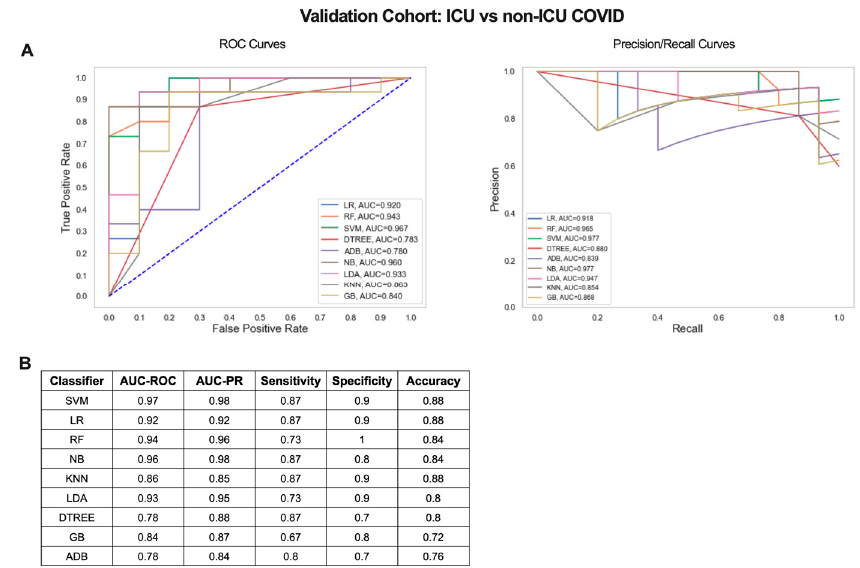
Figure 6. Critical vs. non-critical COVID-19 classifier gene signature validation results. ( A ) ROC and PR curves and ( B ) table of performance metrics for ML results using the 20 gene signature from Figure 4D to compare ICU and non-ICU COVID-19 patients in an independent validation cohort.